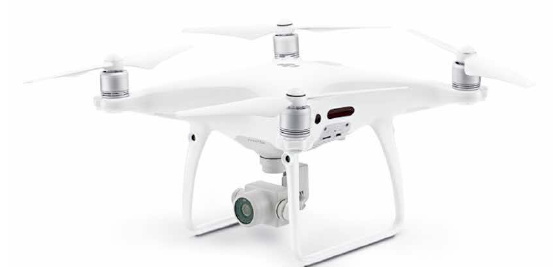
Figure 5. DJI Phantom 4 Pro. Source: www.dji.com